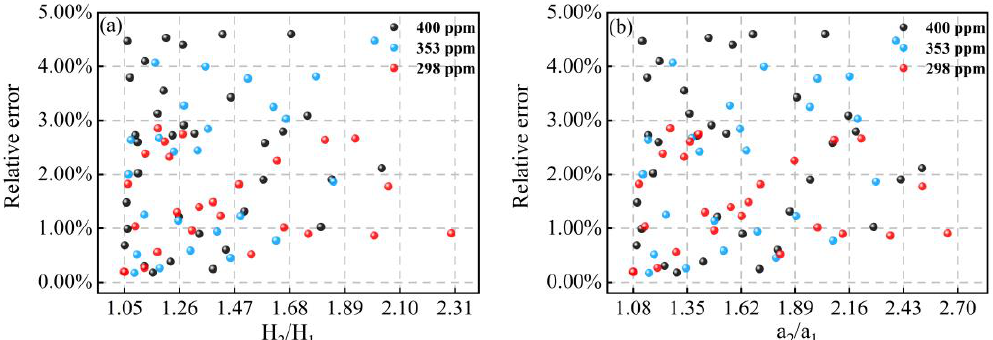
Figure 7. Relative errors of line width for different concentrations of CH 4 with different 2f-peaks ratios ( a ) and modulation amplitude ratios ( b ).